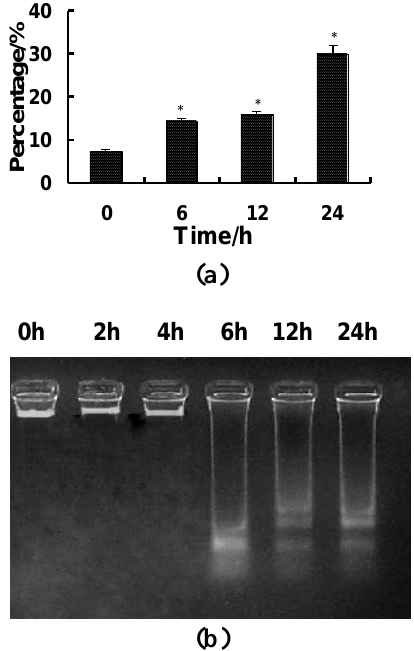
Figure 1. The variation of mammary epithelial cells treated with TGF-  1 . (a) The apoptosis ratio of mammary epithelial cells treated with TGF-  1 ; (b) The DNA fracture of bovine mammary epithelial cells treated with TGF-  1 . * Indicates a significant difference between two groups